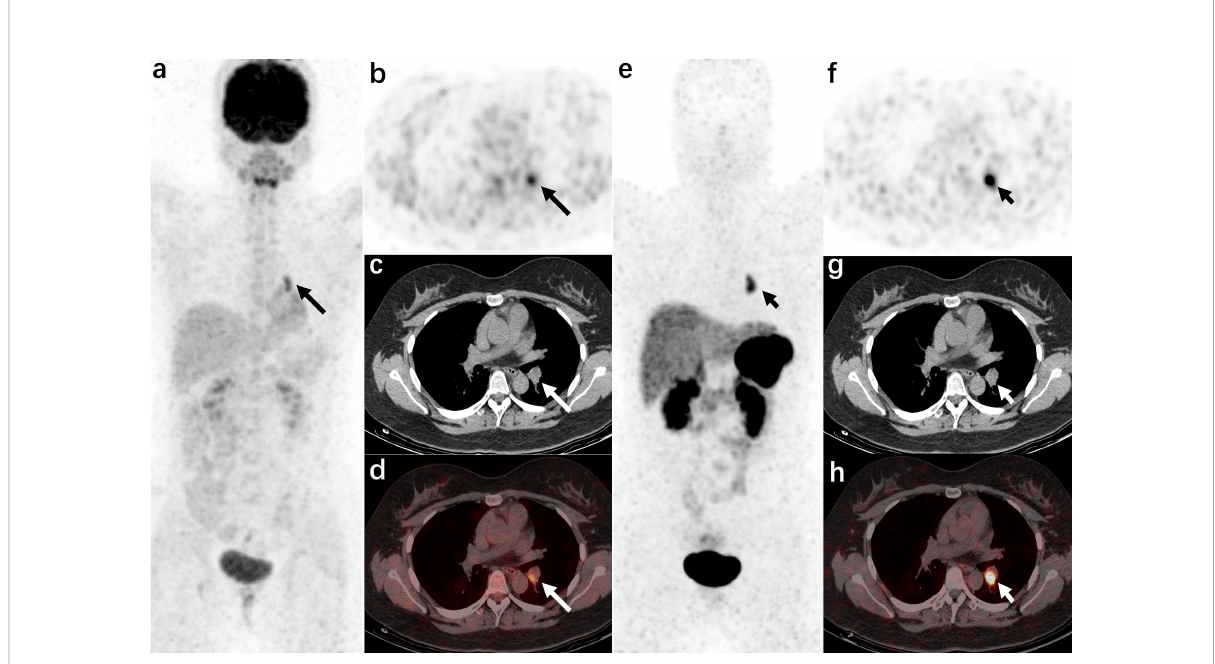
FIGURE 1 A 21-year-old woman was admitted to the hospital due to “ a round face and weight gain for 7 months ” (carcinoid of bronchi, case 21 in the localization group) The left hilar nodule was misdiagnosed as a lymph node by CT. 18 F-FDG PET/CT [ (A) : MIP image, (B) : axial PET, (C) : axial CT, (D) : axial PET/CT fusion image] and 68 Ga-DOTANOC PET/CT [ (E) : MIP image, (F) : axial PET, (G) : axial CT, (H) : axial PET/CT fusion image]. The radiotracer uptake increased in both examinations (the lesions in the 18 F-FDG PET/CT images are shown by long arrows, and the lesions in the 68 Ga-DOTANOC PET/CT images are shown by short